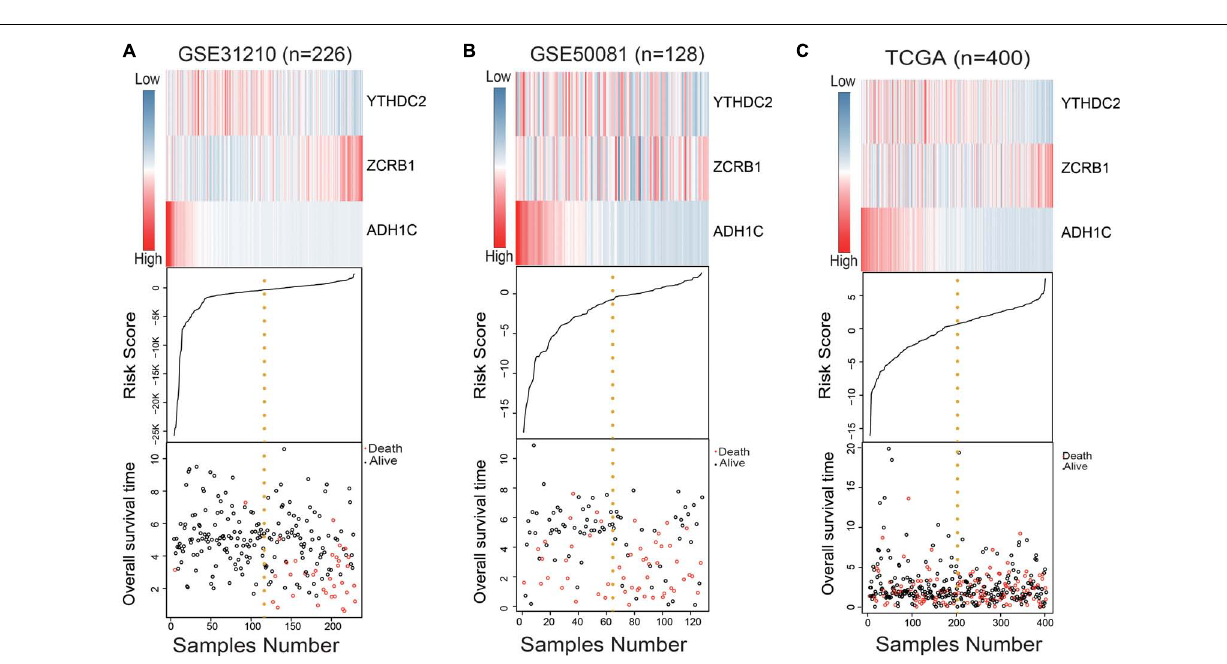
the training set (GSE31210). In LUAD, a total of 5,486 m 6 A- regulated genes were downloaded from the m 6 Avar database 1 (Zheng et al., 2018). Among the 5,507 genes, 2,615 genes were expressed in